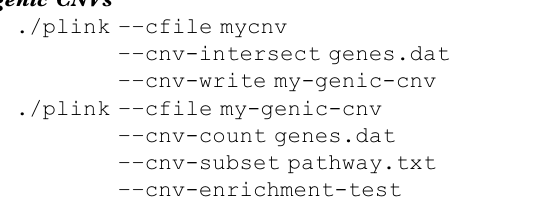
Table S3 Collections examined in this study. Our study